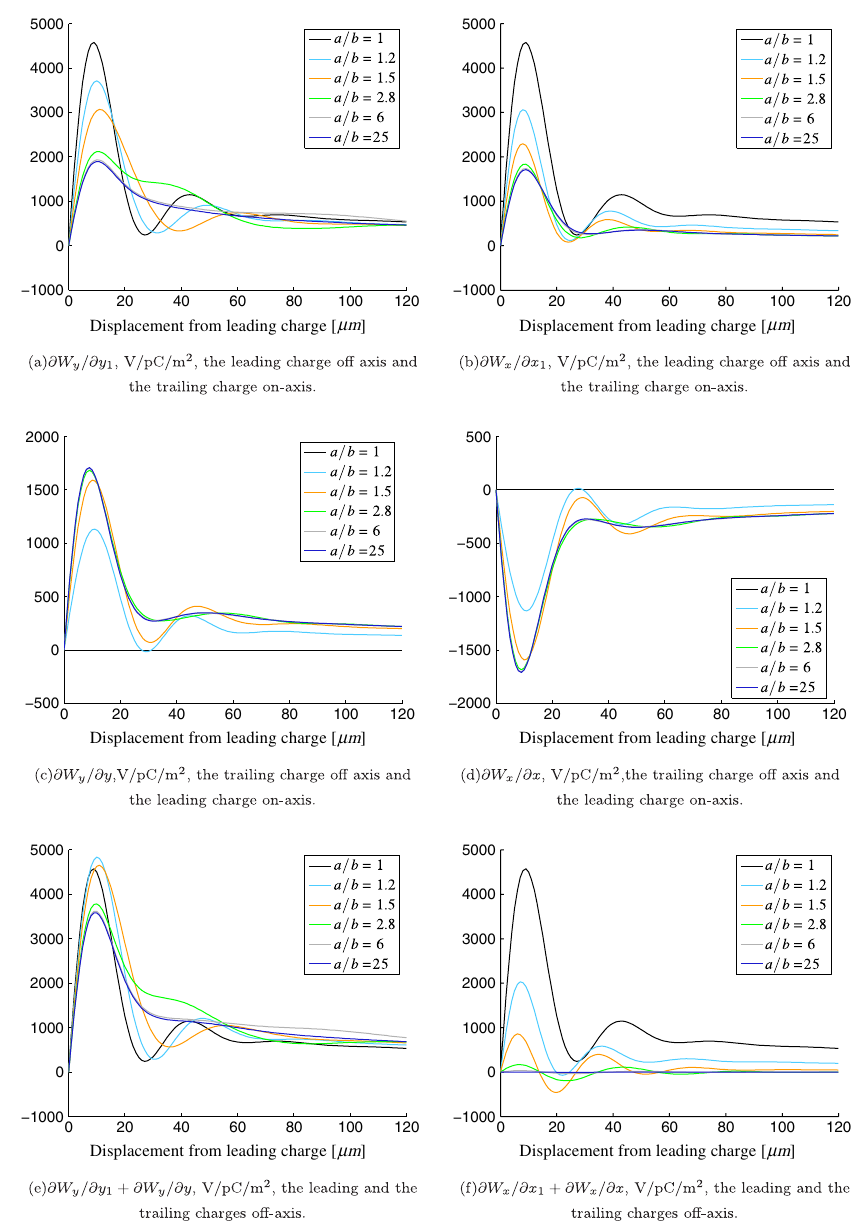
FIG. 7. (Color) Dependence of transverse wake functions on the longitudinal displacement behind the leading charge in a small region around the vacuum chamber axis. Semiminor axis b (cid:4) 3 mm and several values of the aspect ratio a=b are considered. AC conductivity model for aluminum is